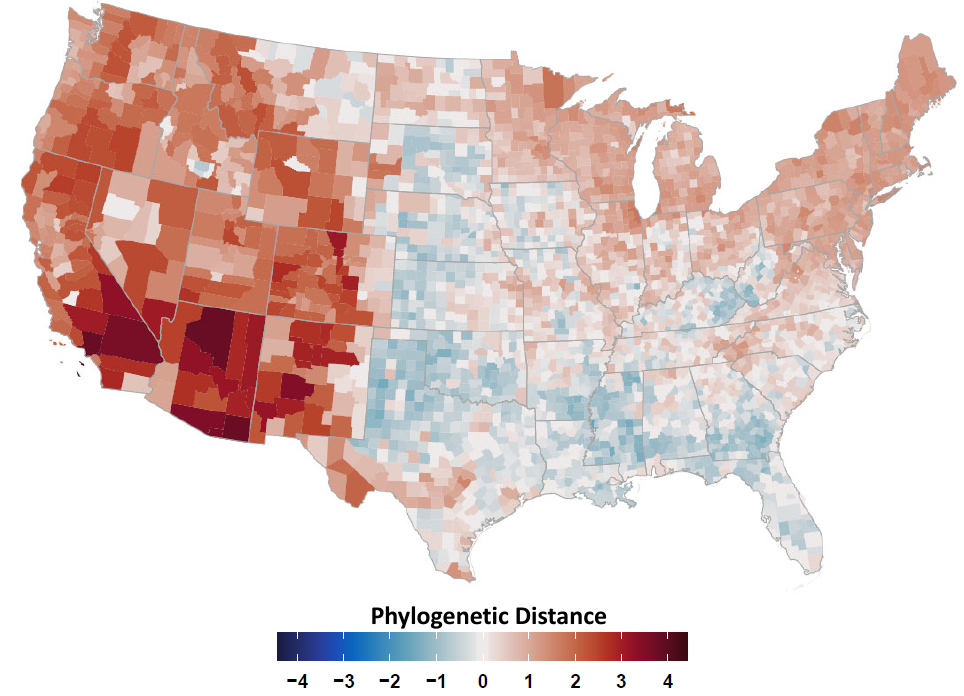
Figure A7. Static avian phylogenetic distance. Phylogenetic distance covariate (sum of branch lengths) under assumption of a static species pool (May–August). Mapped values have been centered to highlight locations subject to relative phylogenetic clustering (higher than expected relatedness, blue colors) and dispersion (lower than expected relatedness, red